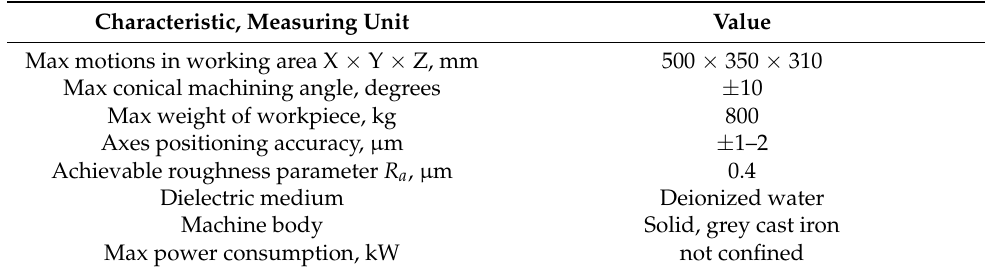
Table 1. Main characteristics of a Seibu M500S wire electrical discharge machine.